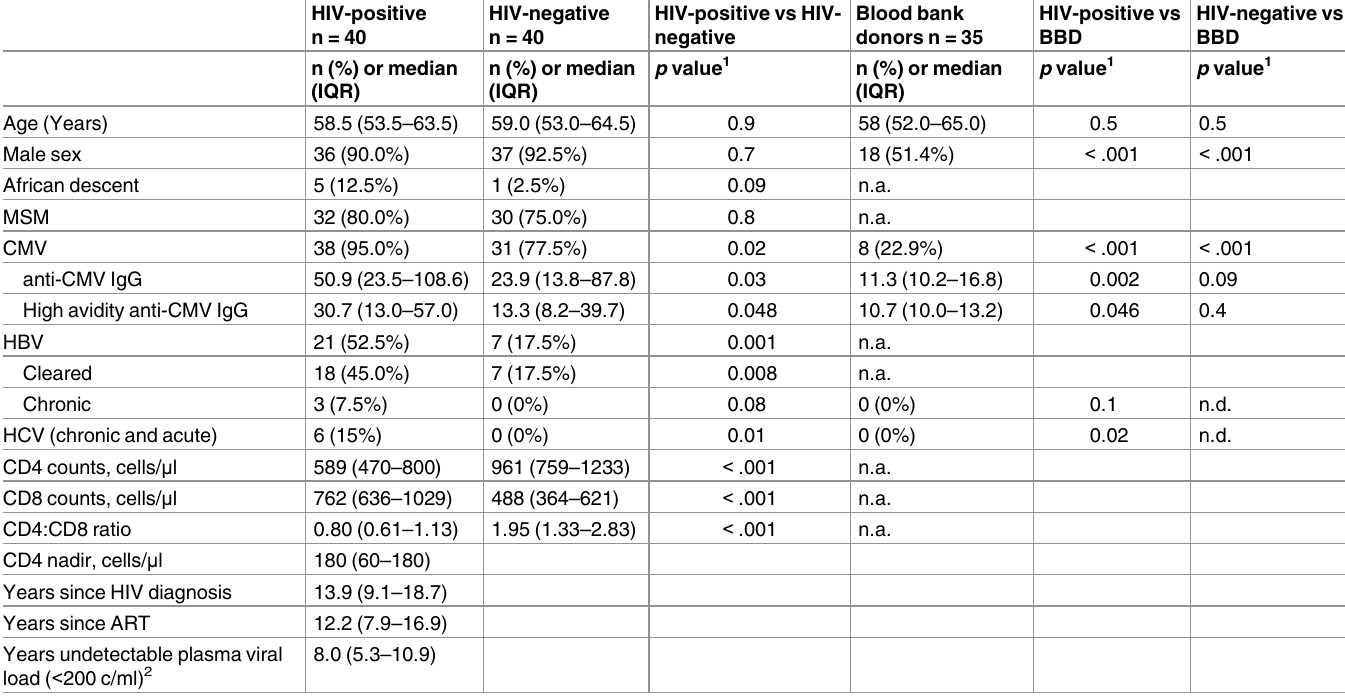
Table 1. Baseline characteristics HIV-positive and HIV-negative COBRA participants and blood bank